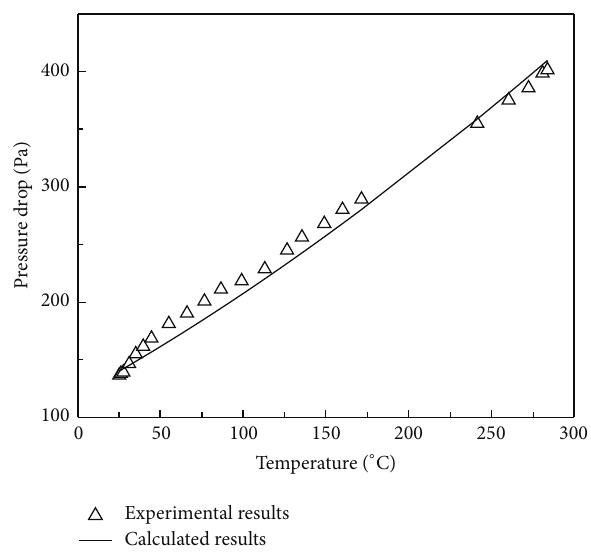
Figure 10: Contrast of the experimental results and the calculated results in the heat exchanger flue gas section.